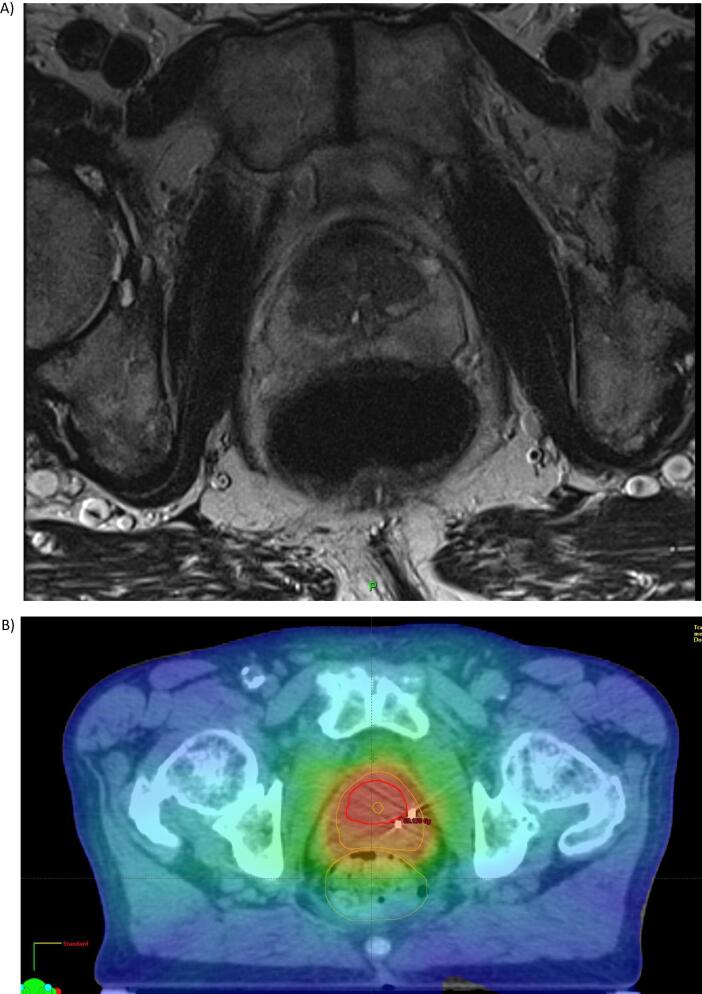
image of a suitable focal prostate boost. A) Multiparametric MRI scan at the mid gland level showing a large tumour in the central zone. B) Corresponding Planning CT scan with dose distribution around the boost volume (red contour) dose level 67 Gy (red colour)), prostate volume (orange line) dose level 60 Gy (orange colour).